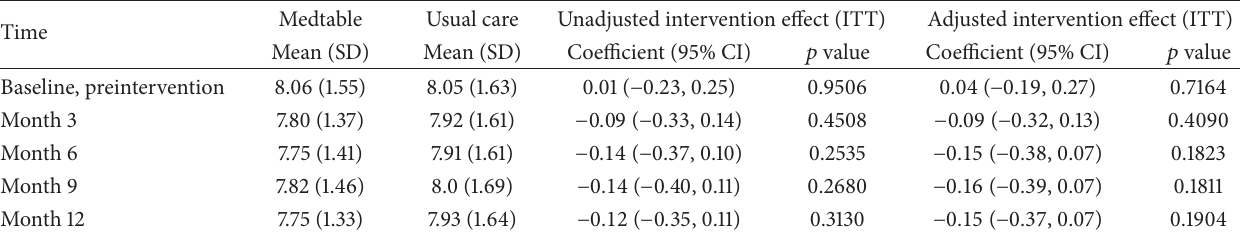
Table 7: Glycosylated hemoglobin (HbA1c) before and after intervention: Medtable versus usual care.